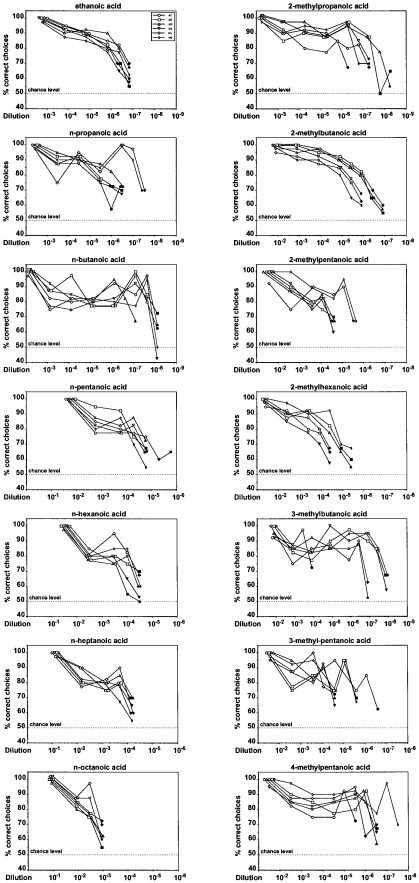
Performance of CD-1 mice in discriminating between various dilutions of an aliphatic carboxylic acid and the solvent.Each data point represents the percentage of correct choices from a total of 40 decisions per individual animal. The six different symbols represent data from each of the six individual animals tested per odorant. Filled symbols indicate dilutions that were not discriminated significantly above chance level (binomial test, p>0.01).